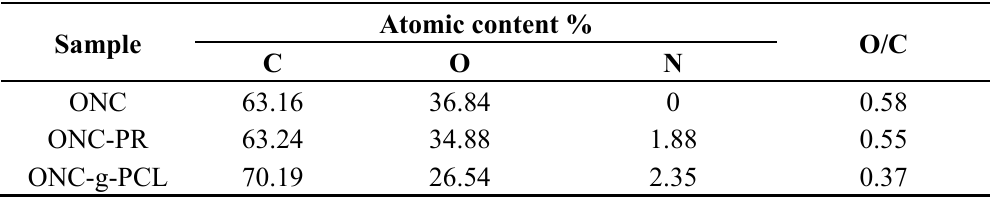
Table 2. Experimental atomic composition and O/C ratio obtained by XPS analysis for ONC, ONC-PR and